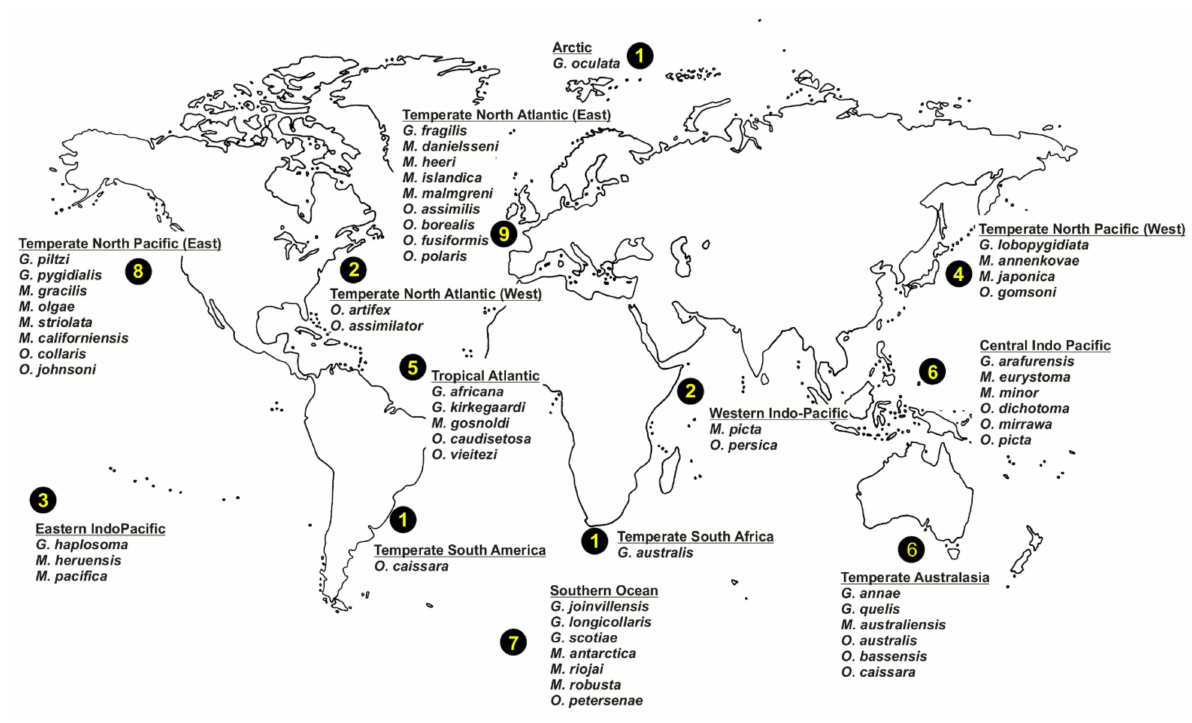
Figure 22. World map showing number of valid oweniid species (sensu [85]) described per bioregion (sensu